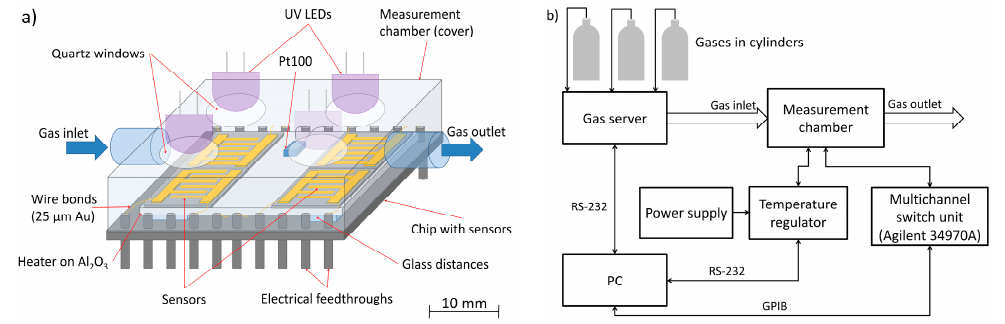
Figure 2. ( a ) Scheme of the measurement chamber; ( b ) Scheme of the measurement stand for gas sensors tests.